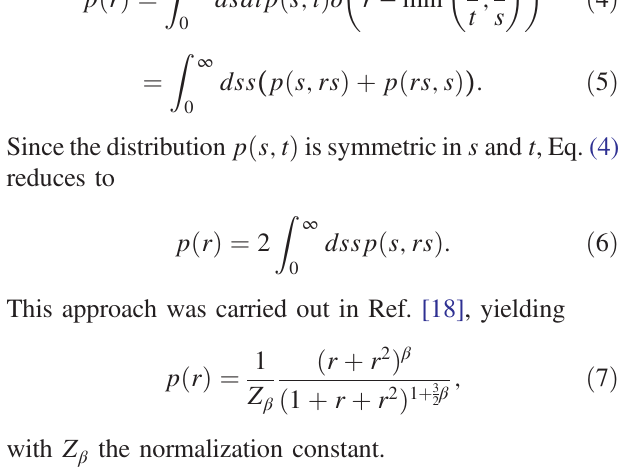
ffiffiffiffiffiffiffiffiffiffiffiffiffiffiffiffi p 2 N − λ 2